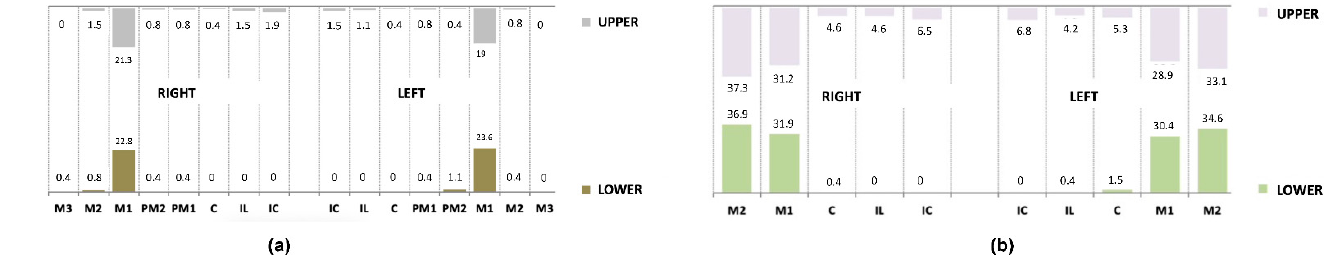
Figure 1. Caries prevalence (%): ( a ) permanent dentition; ( b ) primary dentition.